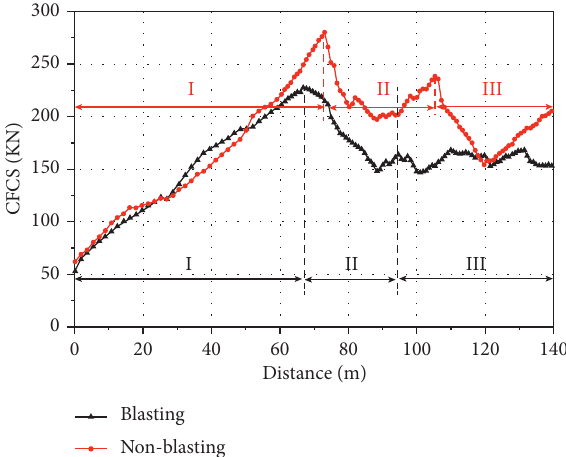
Figure 12: Variation curves of CFCS in the key